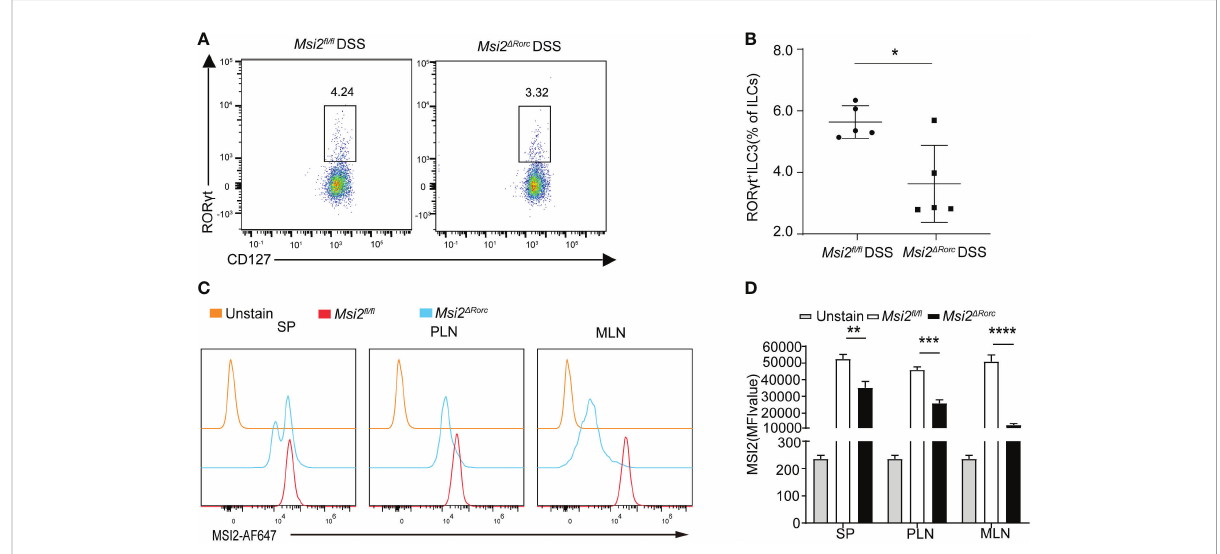
FIGURE 1 Deletion of MSI2 expression affects the ILC3s of Msi2 D Rorc mice. (A, B) Flow cytometry measured the percentage of ILC3s in the colon of Msi2 fl / fl and Msi2 D Rorc mice after DSS-induced colitis. (C, D) The mean fl uorescence intensity of MSI2 in ILC3 cells of the spleen, peripheral lymph nodes and mesenteric lymph nodes in Msi2 fl / fl and Msi2 D Rorc mice. Data represent the means ± SEMs (n = 5). *p < 0.05, **p < 0.01, ***p < 0.001, ****p <